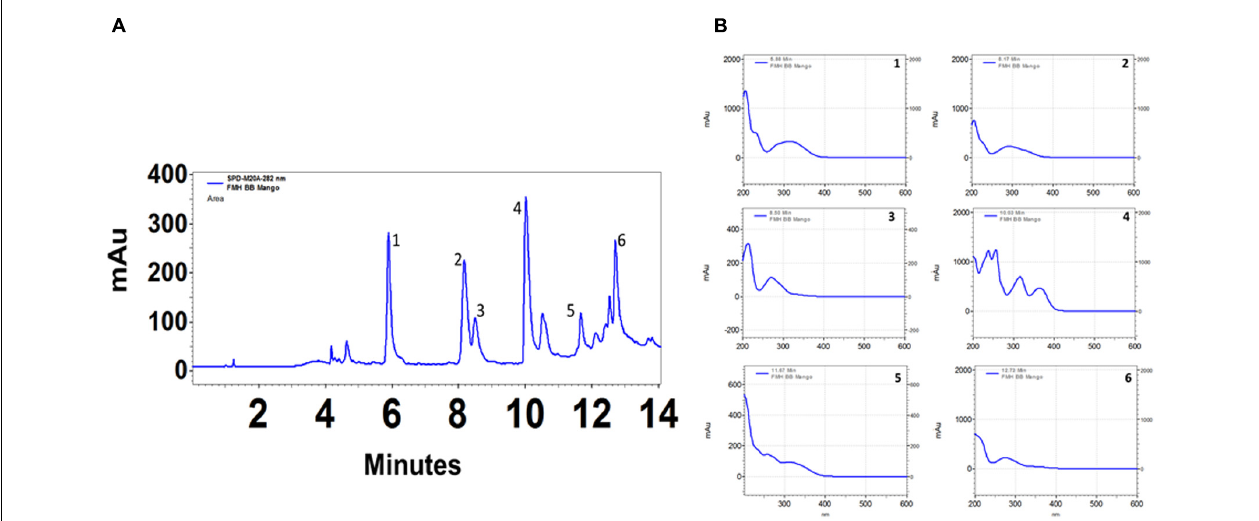
FIGURE 6 | HPLC profile of Mangifera indica (methanol) leaf extract. Twenty microliter of extracts (1 mg/ml) were injected and analyzed using photo diode array detector on a C18 (250 mm × 4.6 mm ID × 5 µ m) reverse phase column in a gradient of 3.5% aqueous phosphoric acid and acetonitrile. Chromatograms in (A) represent various polyphenolics detected at 280 nm. Chromatograms in the (B) represent analysis of different peaks as indicated in (A) in the range of 200–600 nm. mAu, milli absorbance units. For clarity of data, y -axis scales are